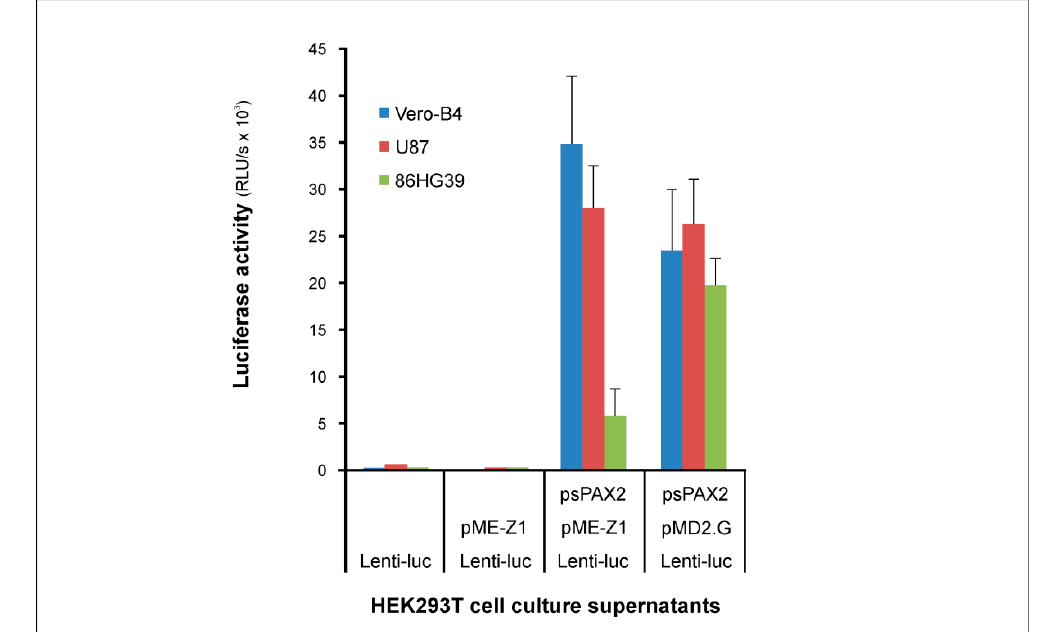
Figure 4. Infection of cells by Z1-LENTI luc. The pseudotype Z1-LENTI luc was synthesized using the three plasmids pME-Z1, psPAX2, and pLenti-luciferase-P2A-Neo (Lenti-luc). Cell culture supernatants from HEK293T transfected cells were tested at 1:5 dilutions on cell layers grown in 96-well cell culture plates. Luciferase activity in target cells was measured at day 3 post infection. Pseudotypes with VSV-G envelope expressed by pMD2.G were used for comparison.